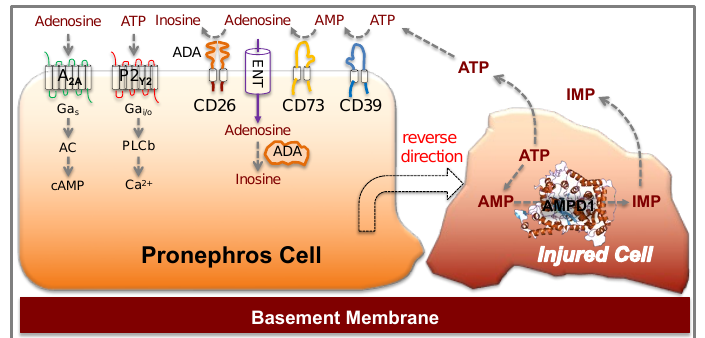
Figure 6. Proposed ATP-dependent signaling after a laser-induced zebrafish pronephros injury. Damaged cells release nucleotides, including ATP. Released ATP is metabolized by ectonucleoside triphosphate diphosphohydrolase-1 (ENTPD1, CD39) and ecto- 5′ -nucleotidase (NT5E, CD73) to adenosine. Adenosine is rapidly removed from the extracellular environment by equilibrative nucleoside transporters (ENTs), or metabolized to inosine by extracellular adenosine deaminase (ADA), associated with CD26 or adenosine receptors. Intracellular adenosine is metabolized by cytoplasmic ADA. The G protein-coupled P2RY2 receptor, signaling through Gi/o, activates PLCß, while the adenosine A2A receptor stimulated adenylyl cyclase (AC) and cAMP production through Gs. Note that other adenosine family members couple to Gi/o, inhibiting AC.